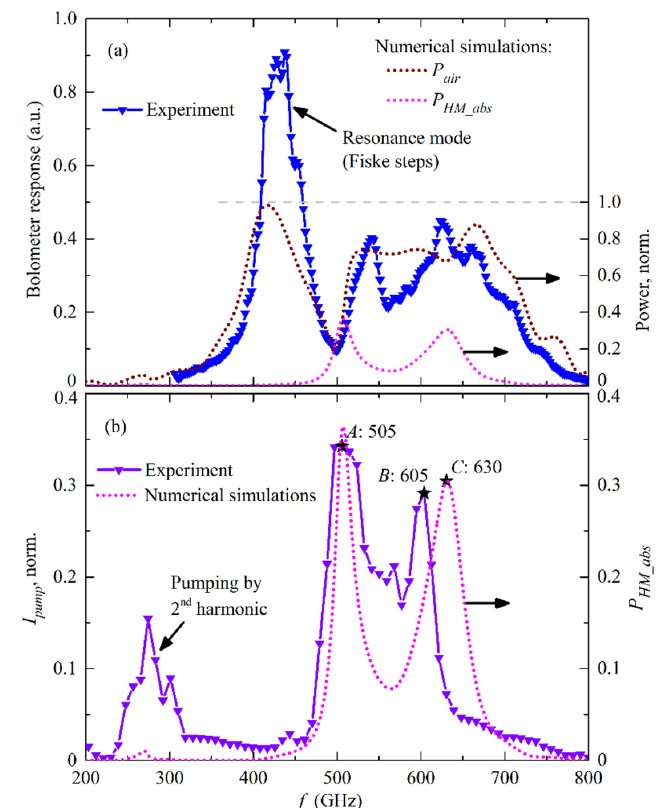
Figure 4. Experimental results compared to numerical simulations of the emitter, designed for the frequency range of 400 to 700 GHz. ( a ) Bolometer response and P air vs. frequency; P HM_abs is plotted in addition for clarity; ( b ) HM pumping current I pump and P HM_abs vs. frequency. I pump is normalized to the SIS “current jump” at V g equal to 144 µA. The curve P HM_abs is the same in ( a , b ) and presented with different scale.